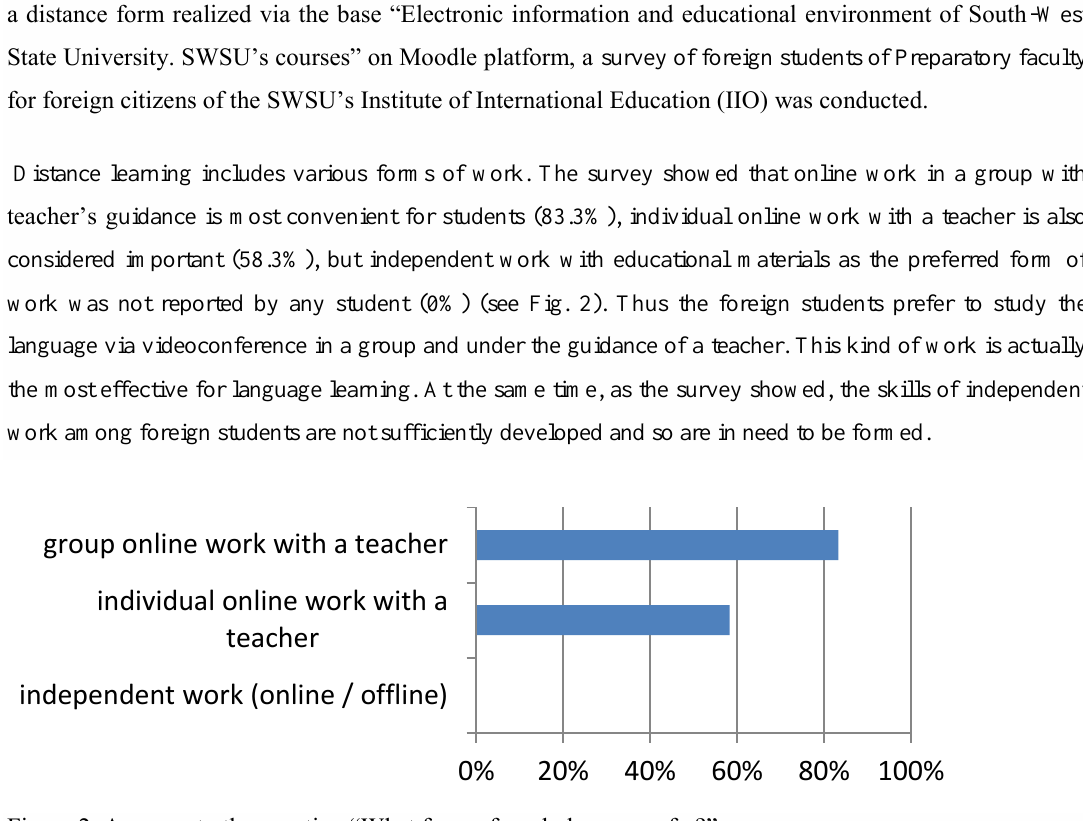
Figure 2. Answers to the question “What form of work do you